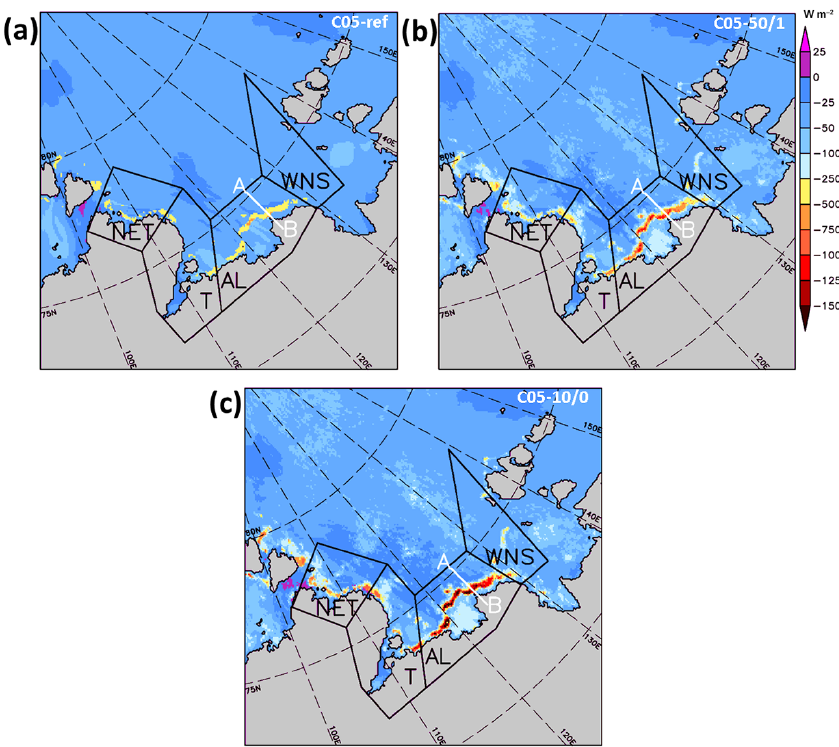
Figure 8. Total atmospheric energy flux on 4 January 2008 at 15:00UTC in (a) C05-ref (reference), (b) C05-50/1 (realistic), and (c) C05-10/0 (open water). Negative fluxes are directed upwards. The white line marks the cross section A → B used for Fig.7.